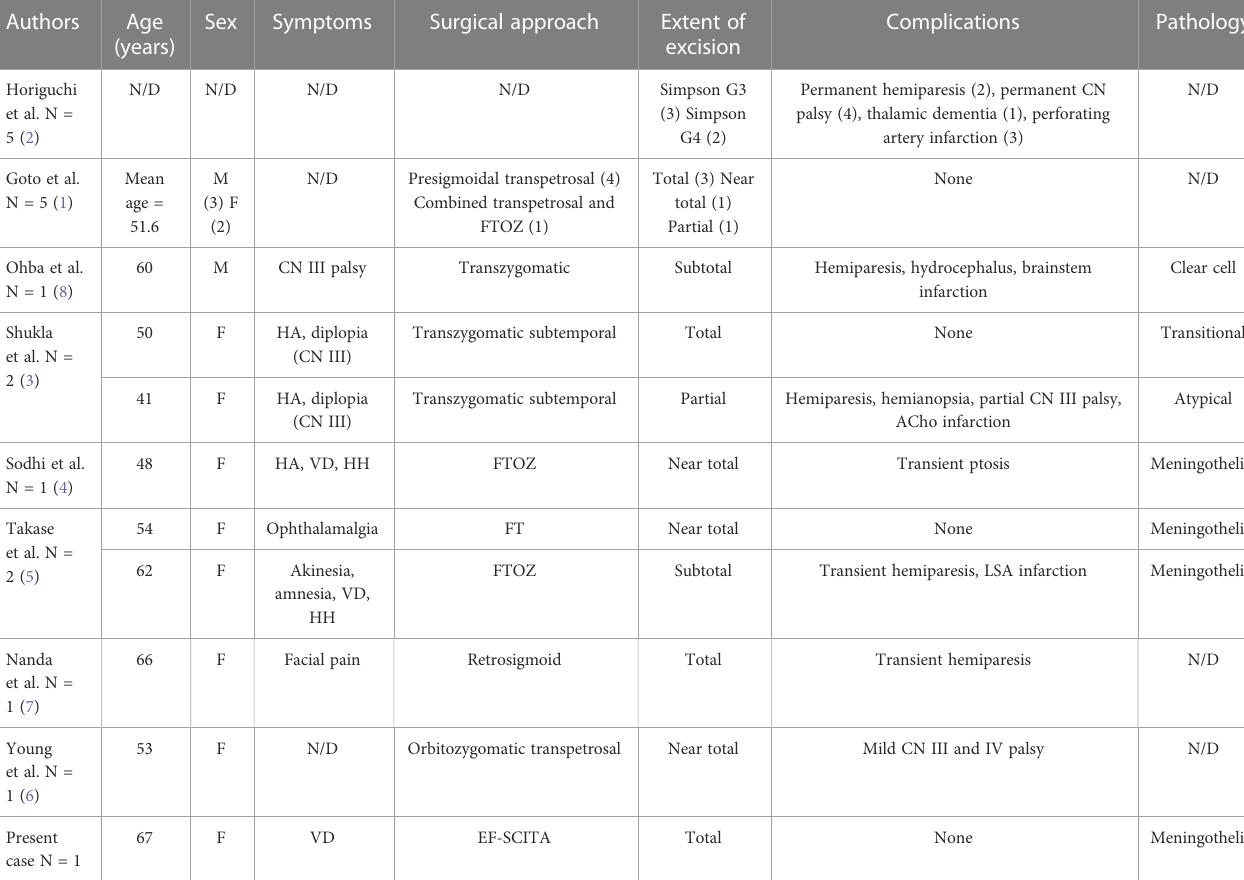
TABLE 1 Summary of reported cases of posterior clinoid